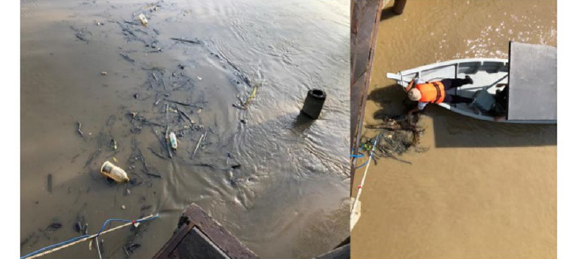
Figure 10. River debris accumulation that interferes with current metre readings The maximum value of speed magnitude data for two days is 1.114 m/s, which was recorded on March 31, 2021 at 17:22:02, whereas the lowest speed is always 0 m/s owing to tide transitions (high-to-low or low-to-high). Additionally, in terms of speed direction, the direction between 0 and 100 degrees denotes high tide, whereas the direction between 200 and 300 degrees shows the study area experienced low tide phenomena.